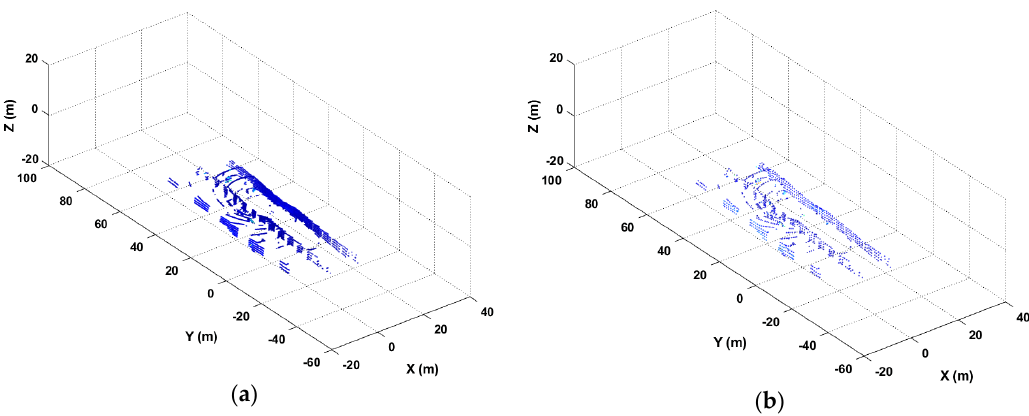
( b ) Figure 7. ( a ) Raw Point Cloud with red circles highlighting the most distinctive points that are removed; ( b ) Denoised Point Cloud. 2.2.5. Point Cloud Downsampling The 3D-LiDAR generates around 300,000 points per second [21]. Therefore, any scan matching algorithm will require high computation power to process the point cloud [22]. So, the downsampling